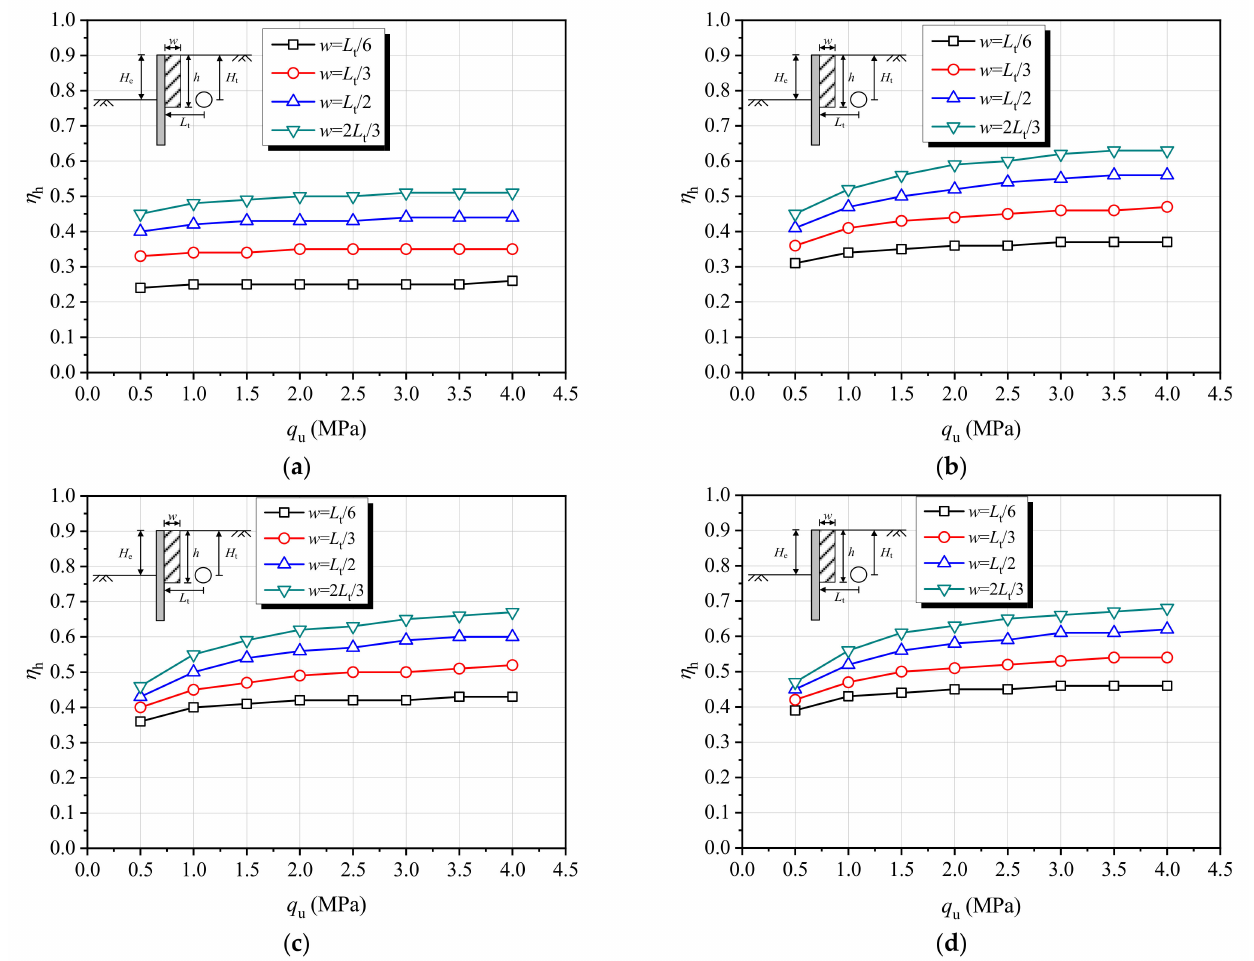
Figure 10. Evolution curves of η h with q u : ( a ) h = 1.5 H t ; ( b ) h = 2.0 H t ; ( c ) h = 2.5 H t ; ( d ) h = 3.0 H t